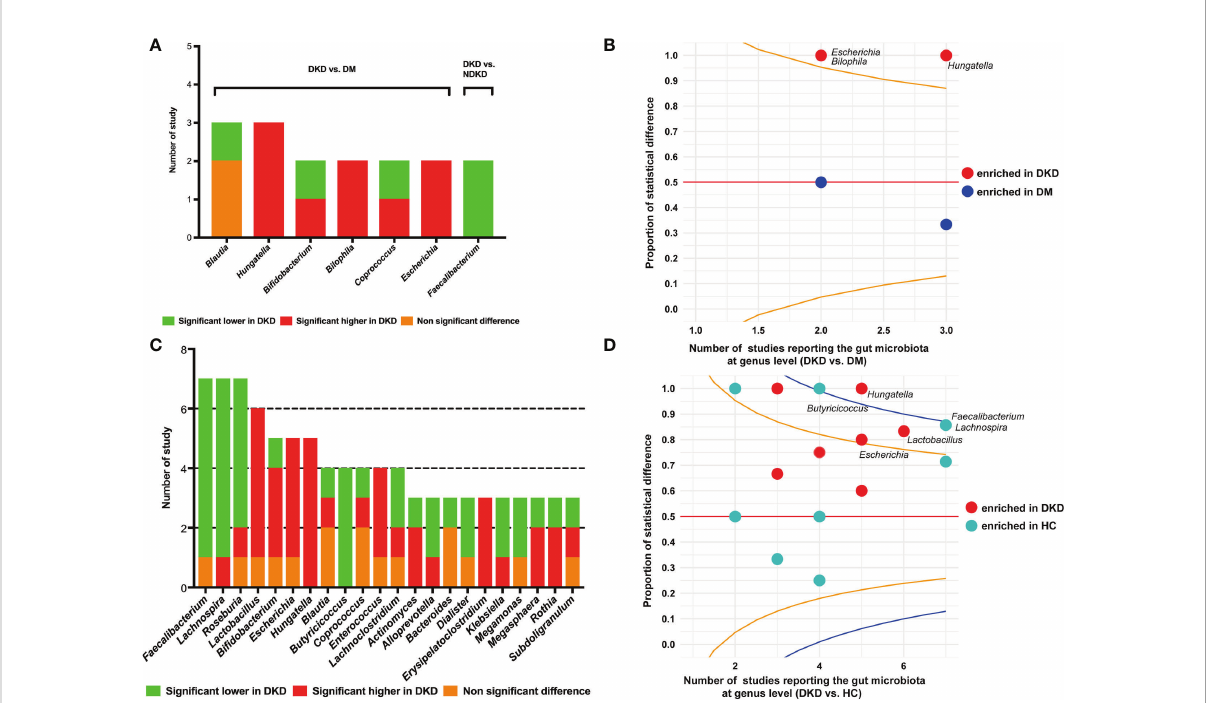
FIGURE 3 Comparisons of gut microbiota at the genus level. (A) The genera reported to be statistically different between DKD and DM, and between DKD and NDKD; (B) The funnel plot conducted between DKD and DM, speci fi ed score2 con fi dence limits were showed at 80% (orange line) and 95% (blue line); (C) The genera reported to be statistically different between DKD and HC; (D) The funnel plot conducted between DKD and HC. DKD, diabetic kidney disease; NDKD, non-diabetic kidney disease; DM, diabetes mellitus; HC, healthy